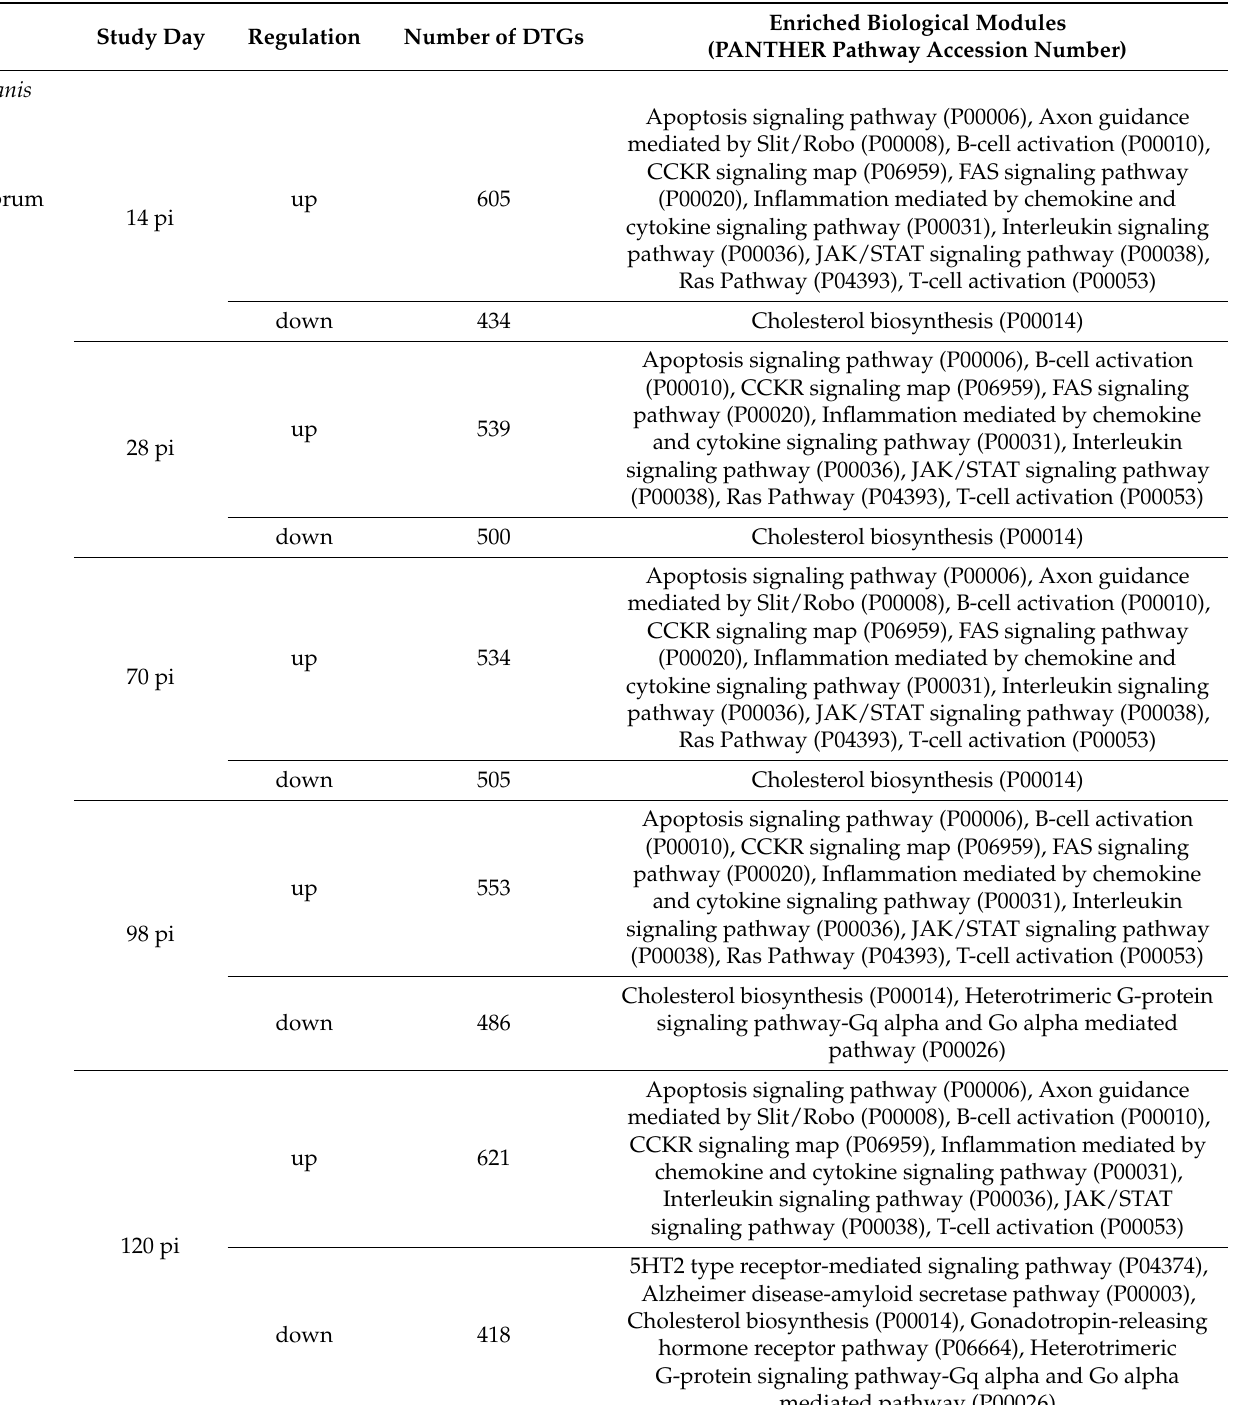
Table 2. Number of differentially transcribed genes (DTGs) in Toxocara canis - and T. cati -infected cerebra and cerebella and enriched biological pathways with an adjusted p -value ≤ 0.05 for each study